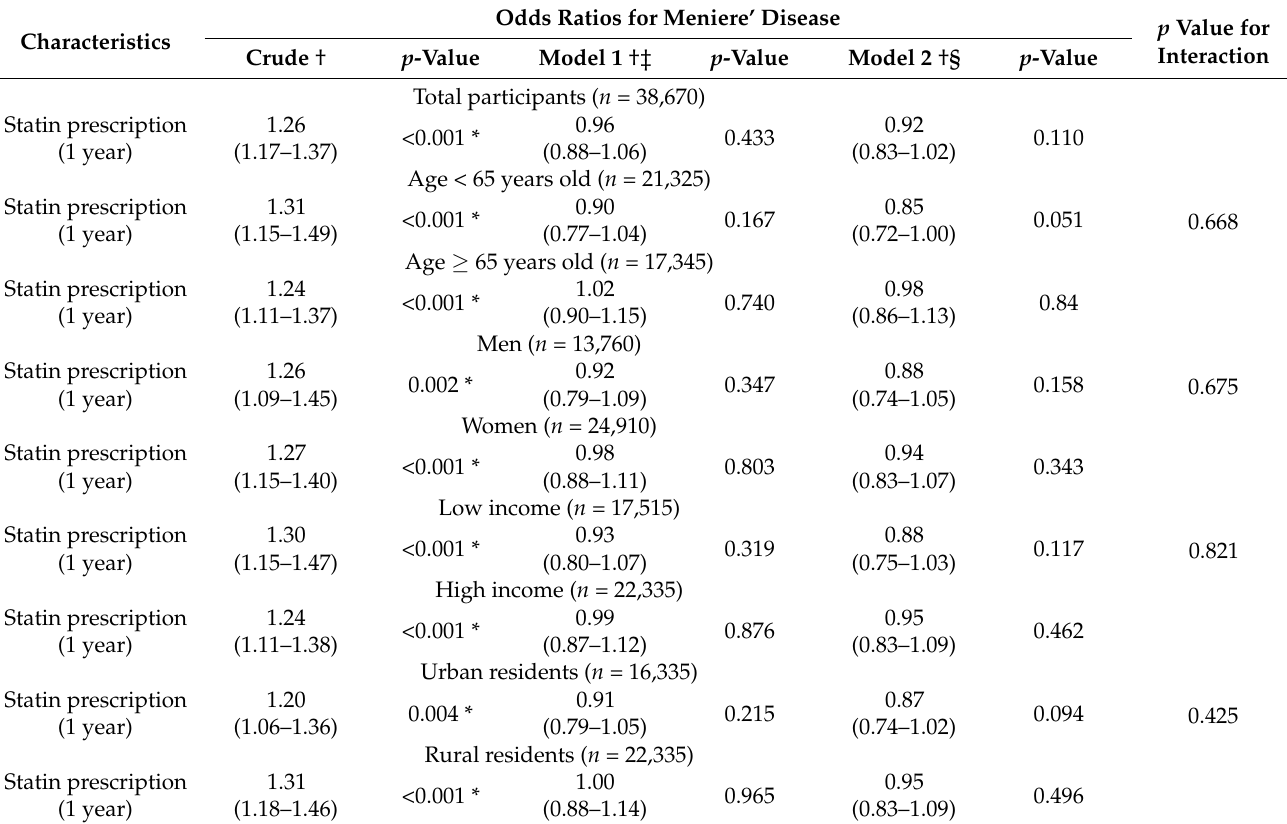
Table 2. Crude and adjusted odd ratios (95% confidence interval) of date of statin prescription (1 year) for Meniere’ disease with stratified subgroup according to age, sex, income, and region of residence.